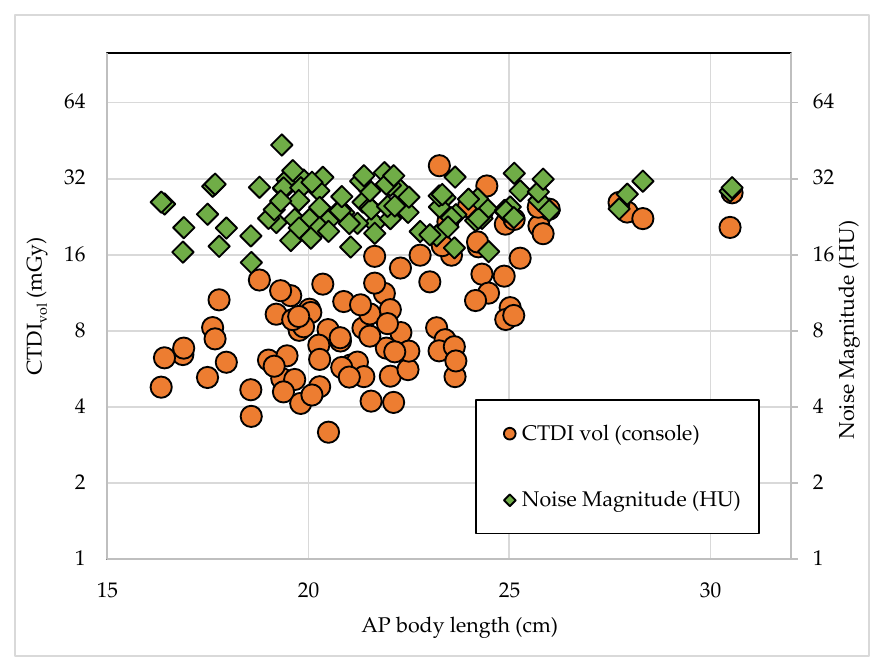
Figure 4. Relationship between the CT dose index volume (CTDI vol ) and noise magnitude with the AP body lengths of the subjects.